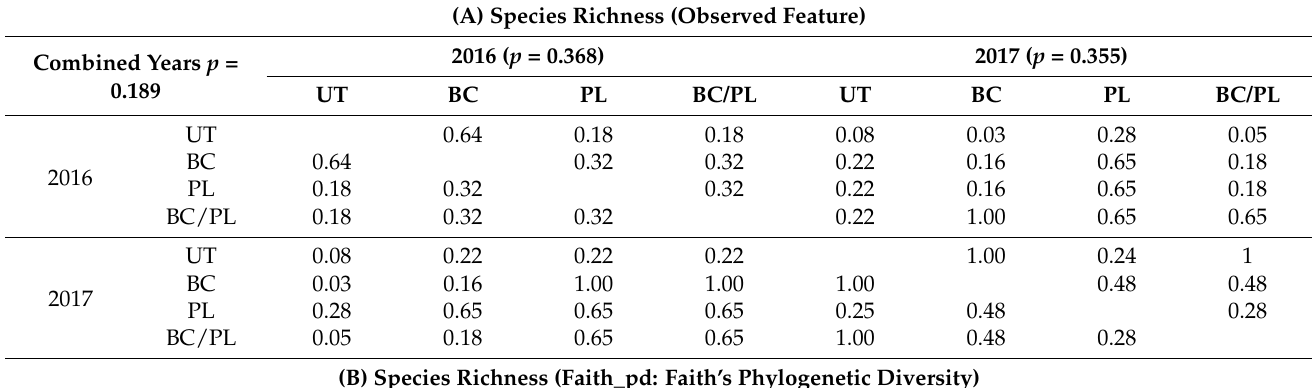
Table 4. Pairwise comparison of the species richness and diversity among the treatments in 2016 and 2017. (A) Species Richness (Observed Feature)